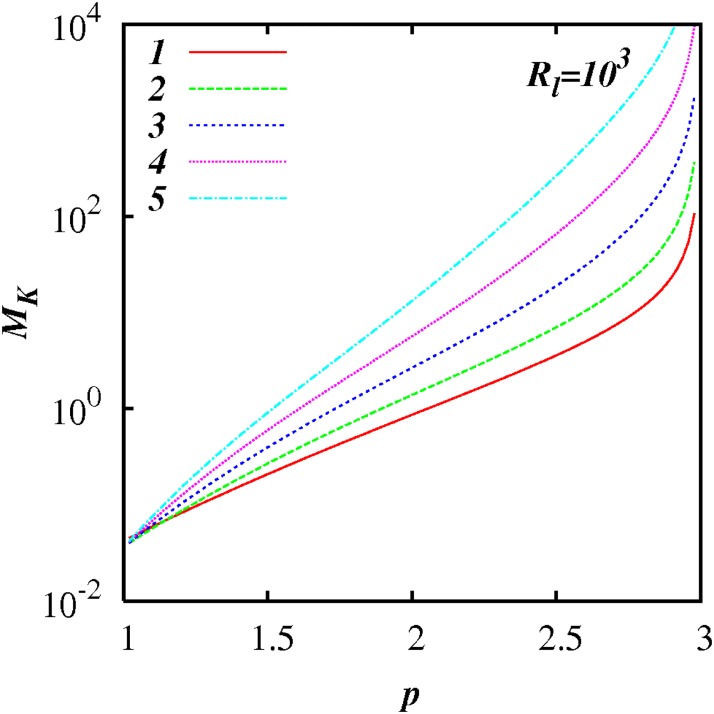
Similar to Fig 3, except for Rl = 103.